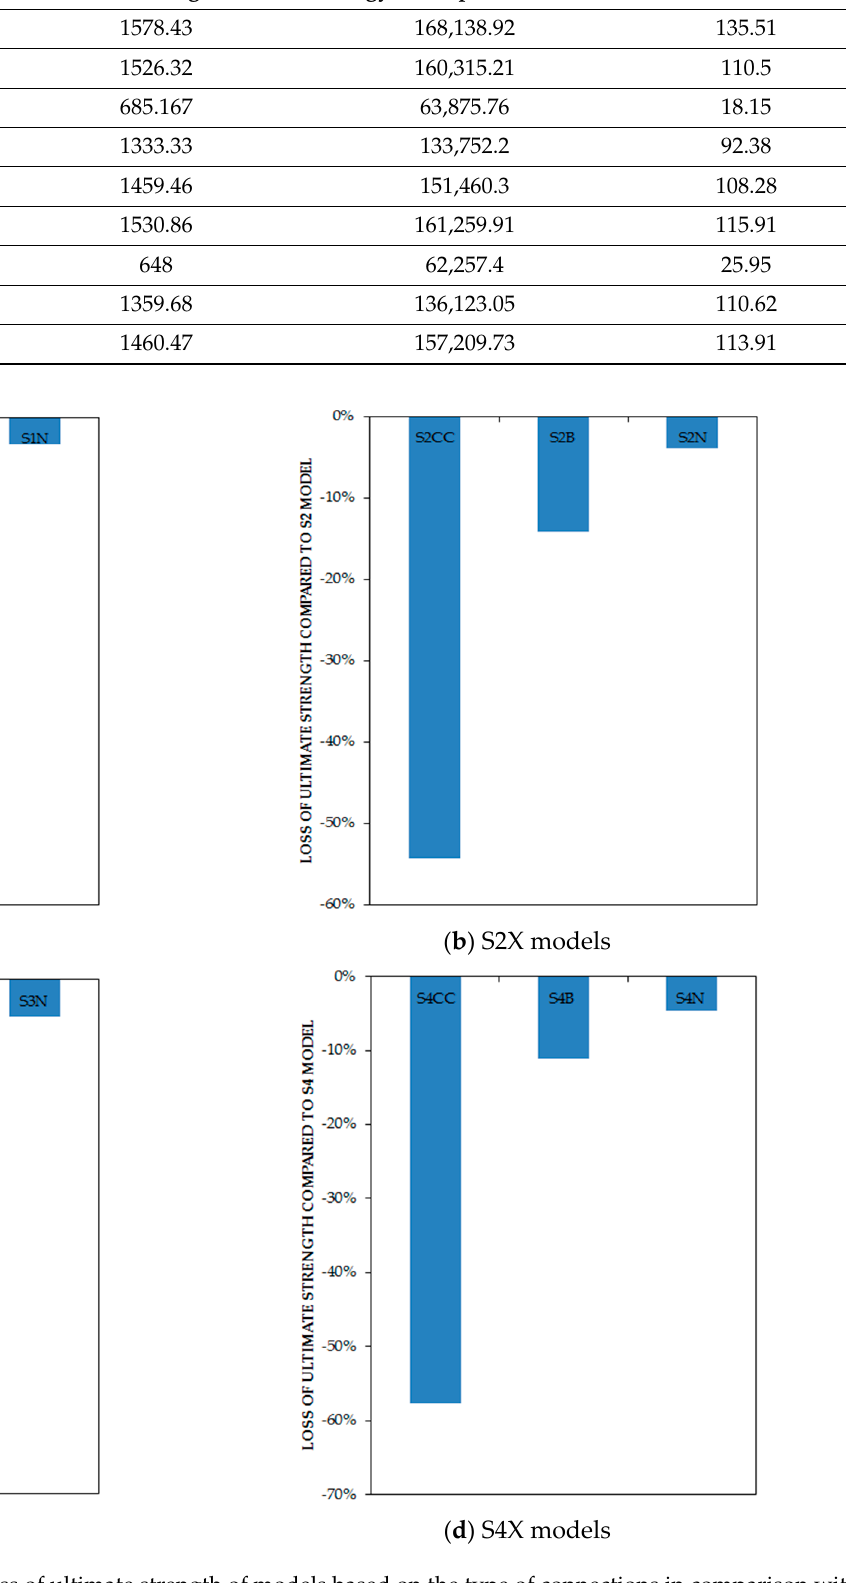
Figure 9. Loss of ultimate strength of models based on the type of connections in comparison with full-connection models by